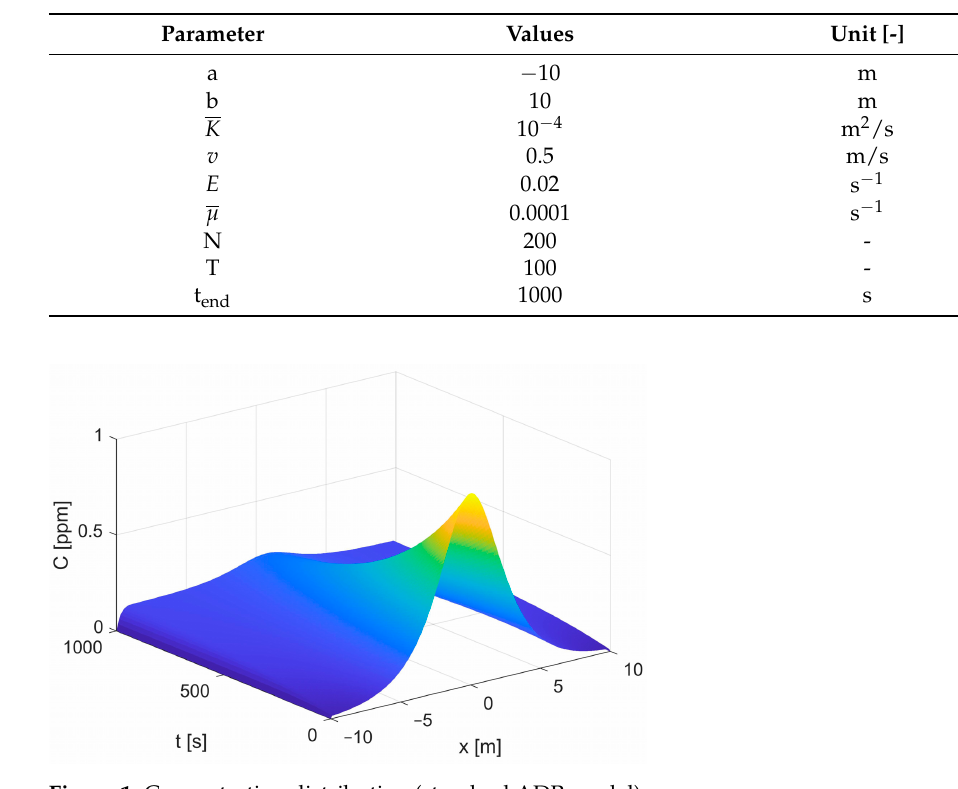
Table 1. Material parameters for FADR analysis.